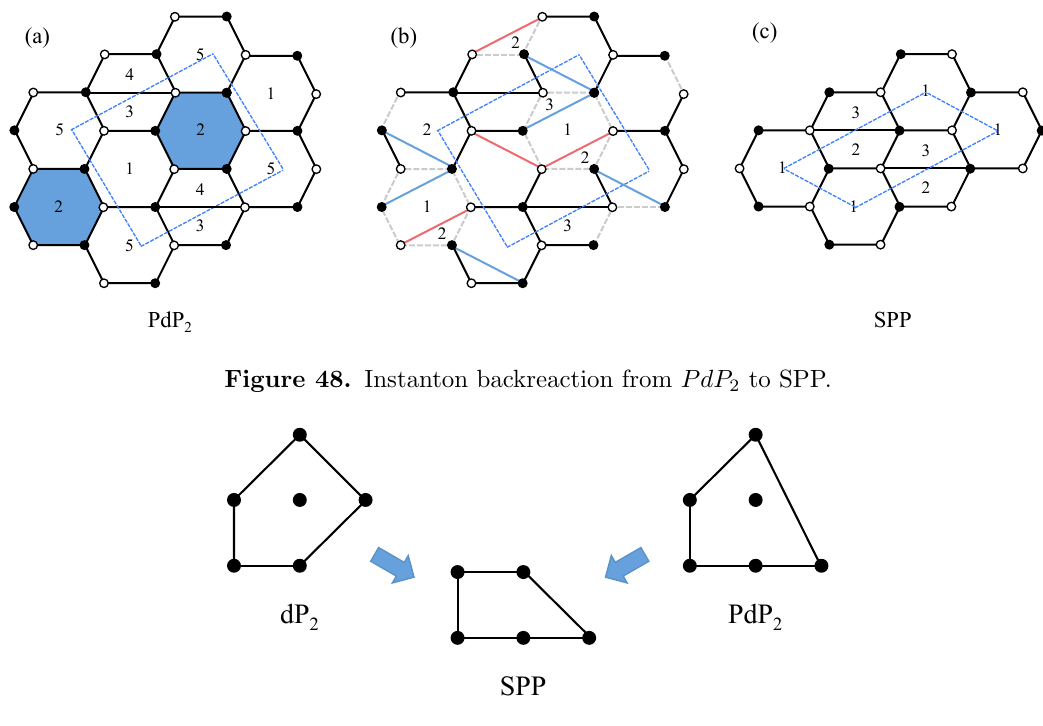
Figure 49. The SPP can be obtained from backreaction of instantons on dP 2 and PdP 2